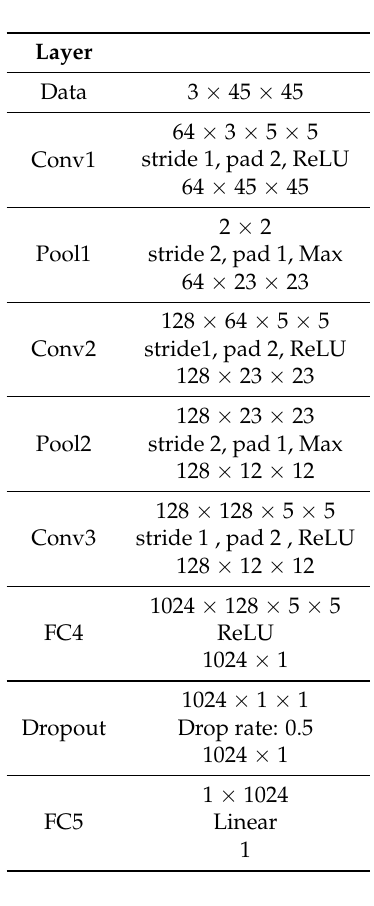
Table 2. Structure and configuration of the CNN model used in the present study. Each row for a given layer corresponds to: the layer dimension (top row), the layer configuration (middle row) and the dimension the output (bottom row). For example for the layer Conv1 there are 64 filters of dimension 3 × 5 × 5 that are applied to an input patch of size 3 × 45 × 45 with a stride of 1 and using a pad 2, to produce an output of dimension 64 × 45 ×